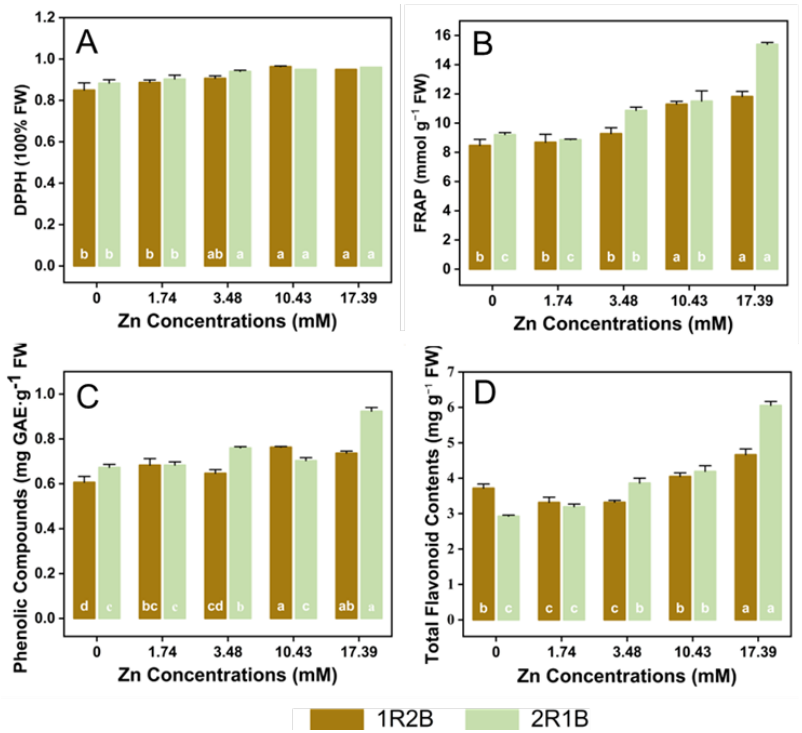
Figure 4. The DPPH (radical inhibition percentage of 1,1-diphenyl-2-picrylhydrazyl) ( A ), FRAP (fer- ric ion-reducing antioxidant power) ( B ) and contents of TP (total phenolic compounds) ( C ) and TF (total flavonoid) ( D ) in flowering Chinese cabbage sprouts (FCCS) grown under combination of Zn concentration and R-B ratio (ratios of red and blue light). The letters marked in all figures indicate the significant difference under Zn treatments ( p ≤ 0.05, Duncan’s test).